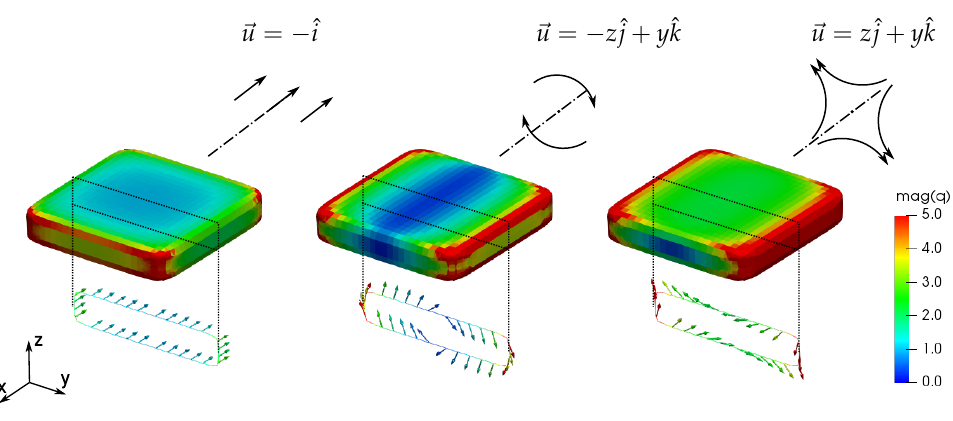
at the surface of a rectangular disc particle, shown for 2